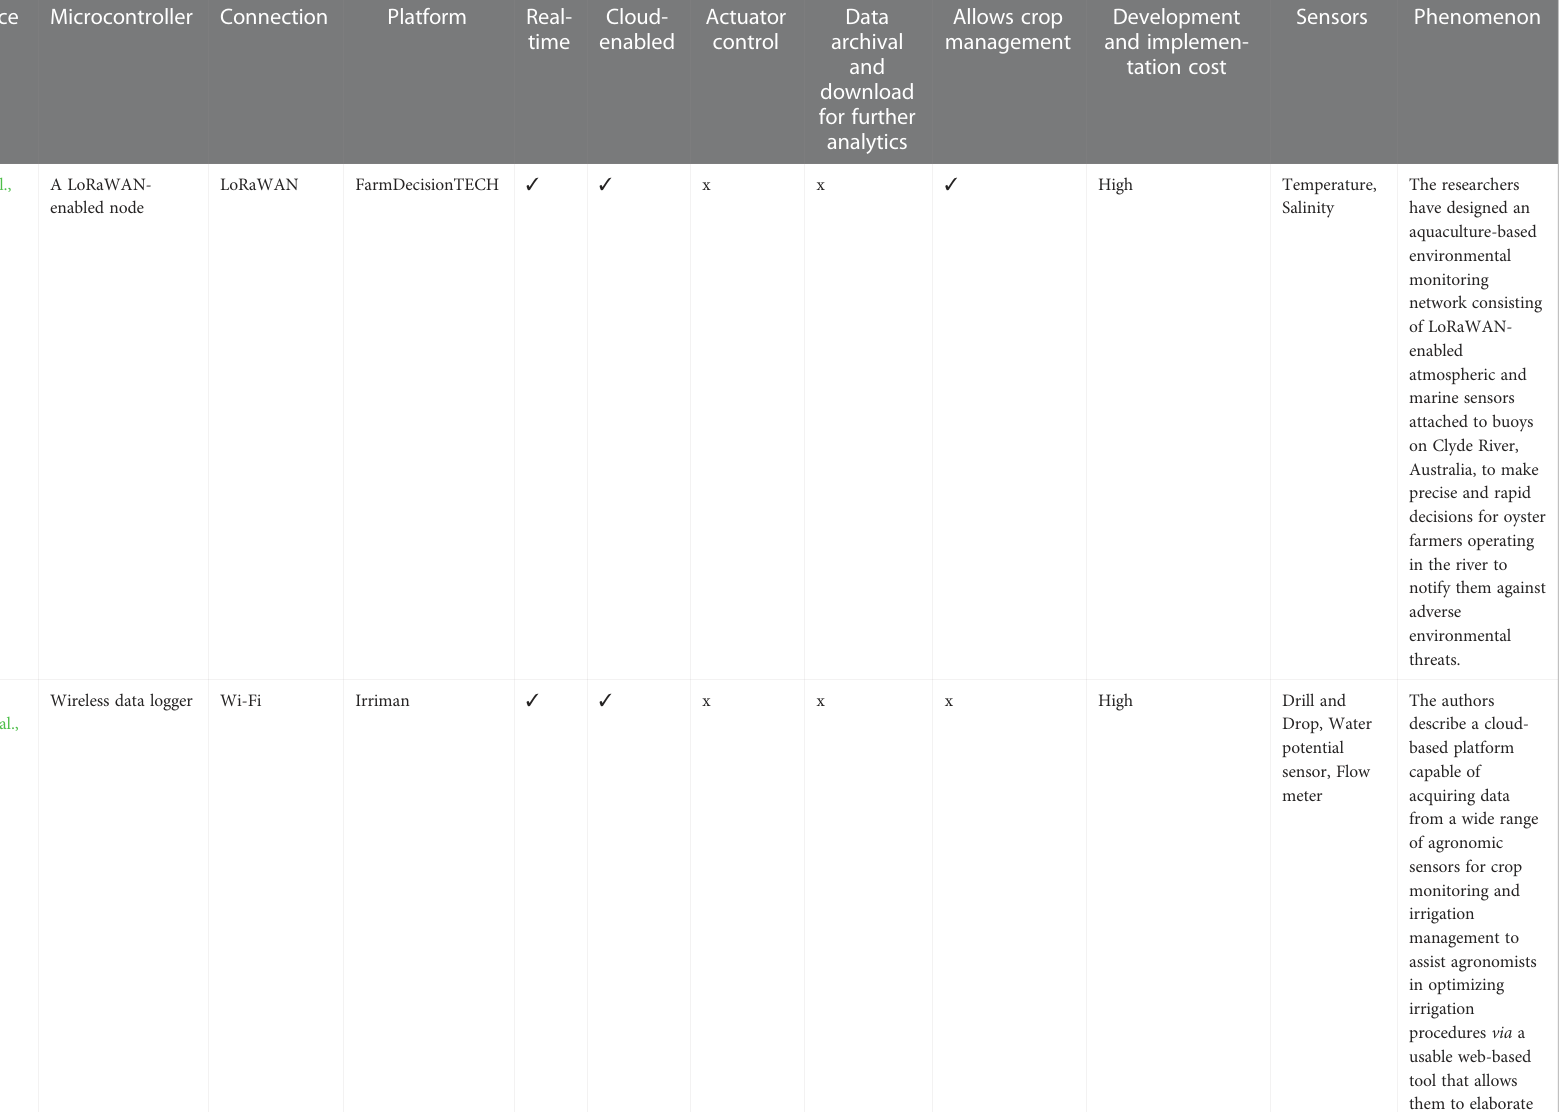
TABLE 4 Comparison between similar